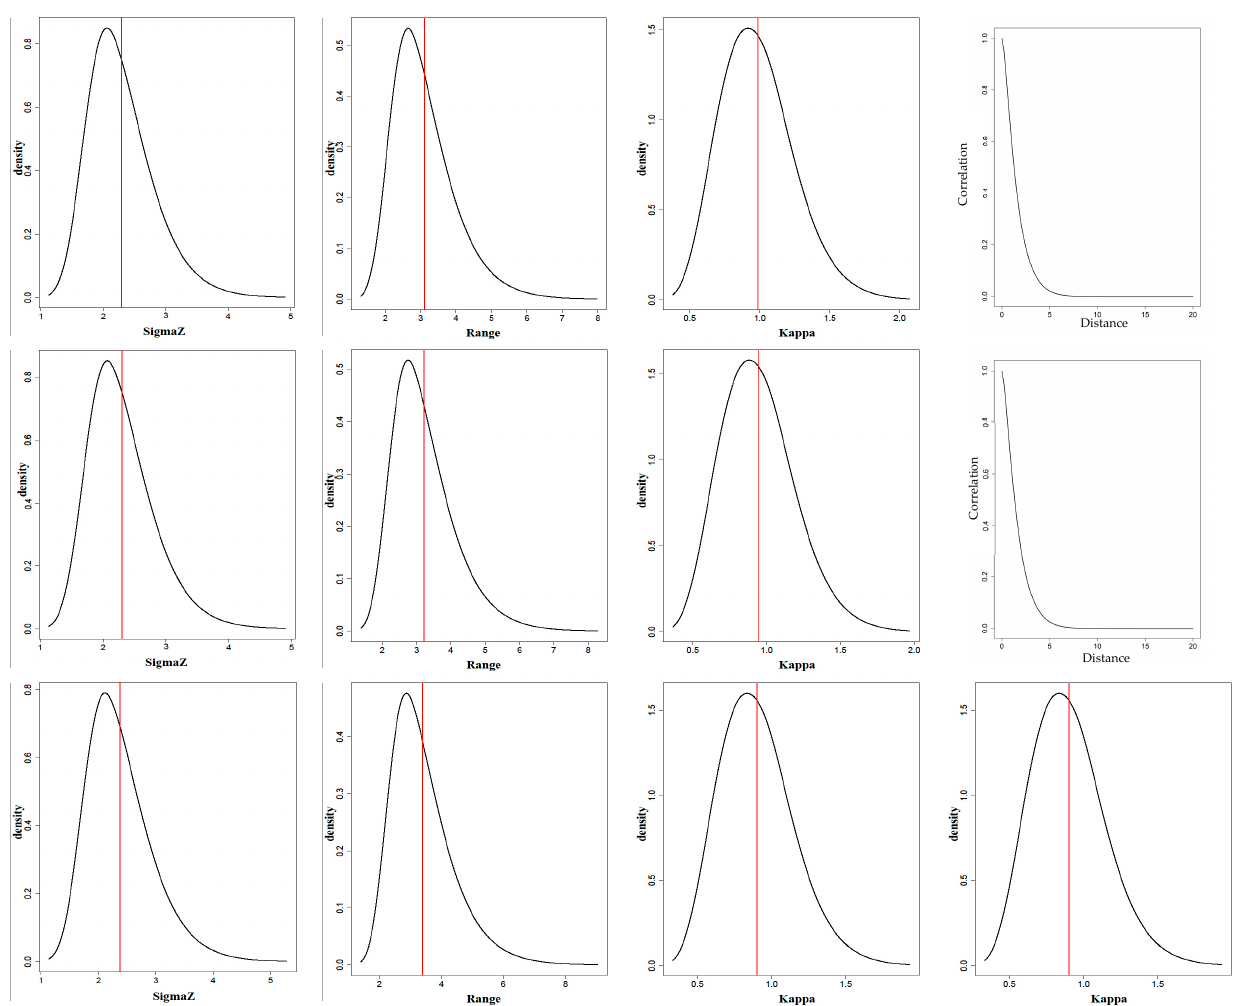
Figure 9. Posterior distribution of parameters and Matern correlation function for the three models. Note: The first, second and third rows show the posterior distribution of the parameters and the Matern correlation function of the stationary Gaussian model, the barrier model and the Multi-Barriers Model, respectively. Table 2. Posterior mean, threshold and DIC values of parameters of the three considered models.